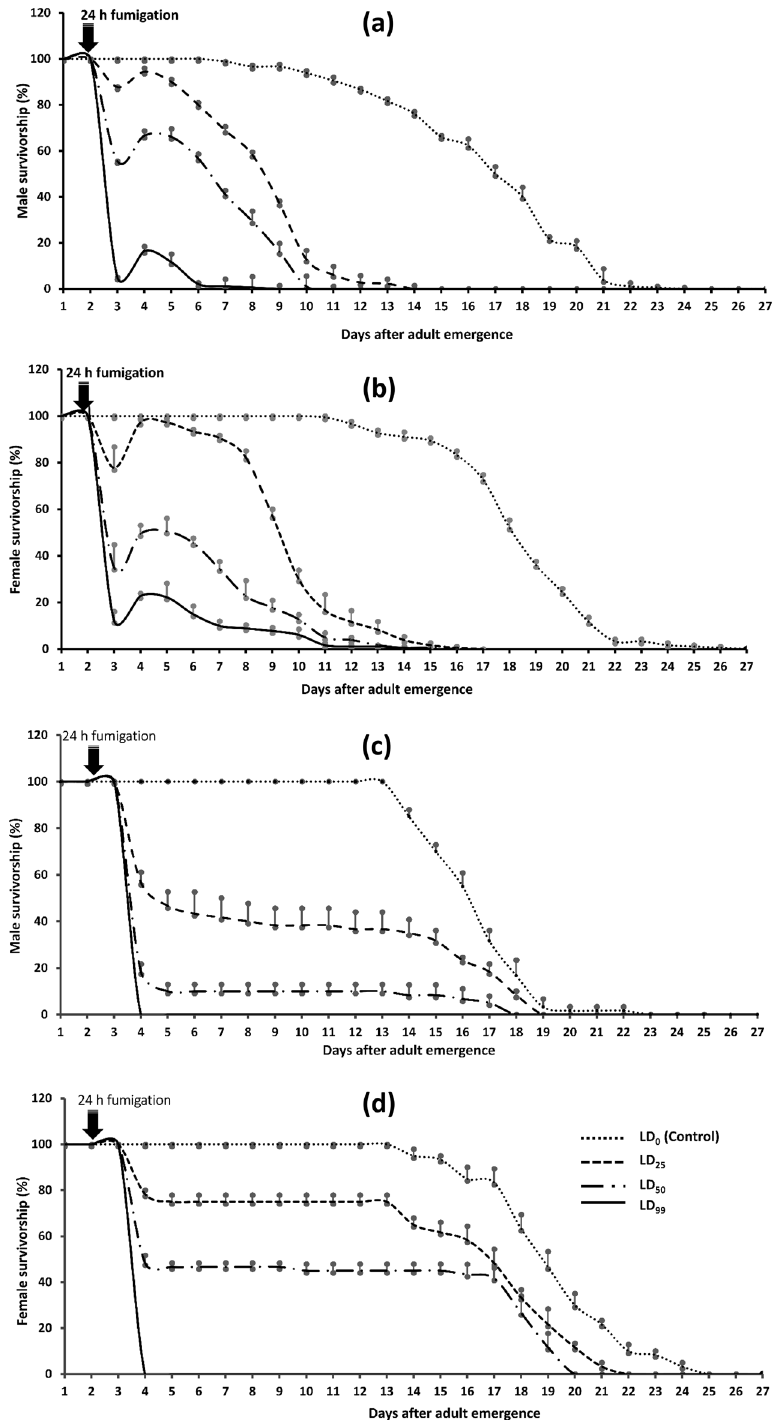
Figure 1. Survivorship curves for virgin C. chinensis adults after fumigation with phosphine (a-male, b-female) and ethyl formate (c-male, d-female) (n = 3, each with 60